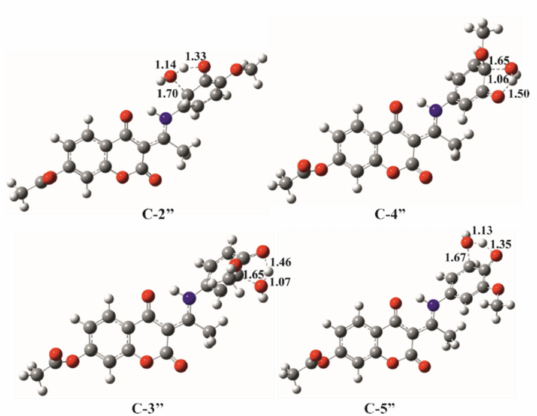
Figure 7. Optimized transition state geometries of the i HAA mechanism at a different position for